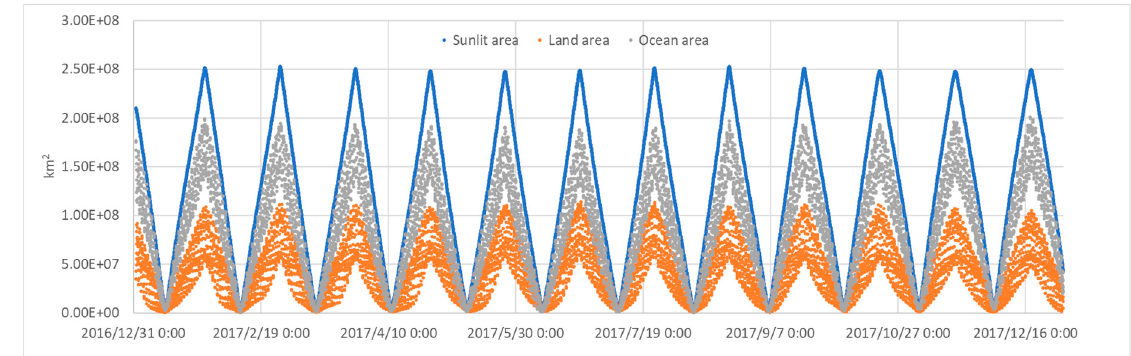
Figure 6. The time series of simulated global mean OSR flux and the global mean shortwave radiance in the Moon-based view, in 2017.